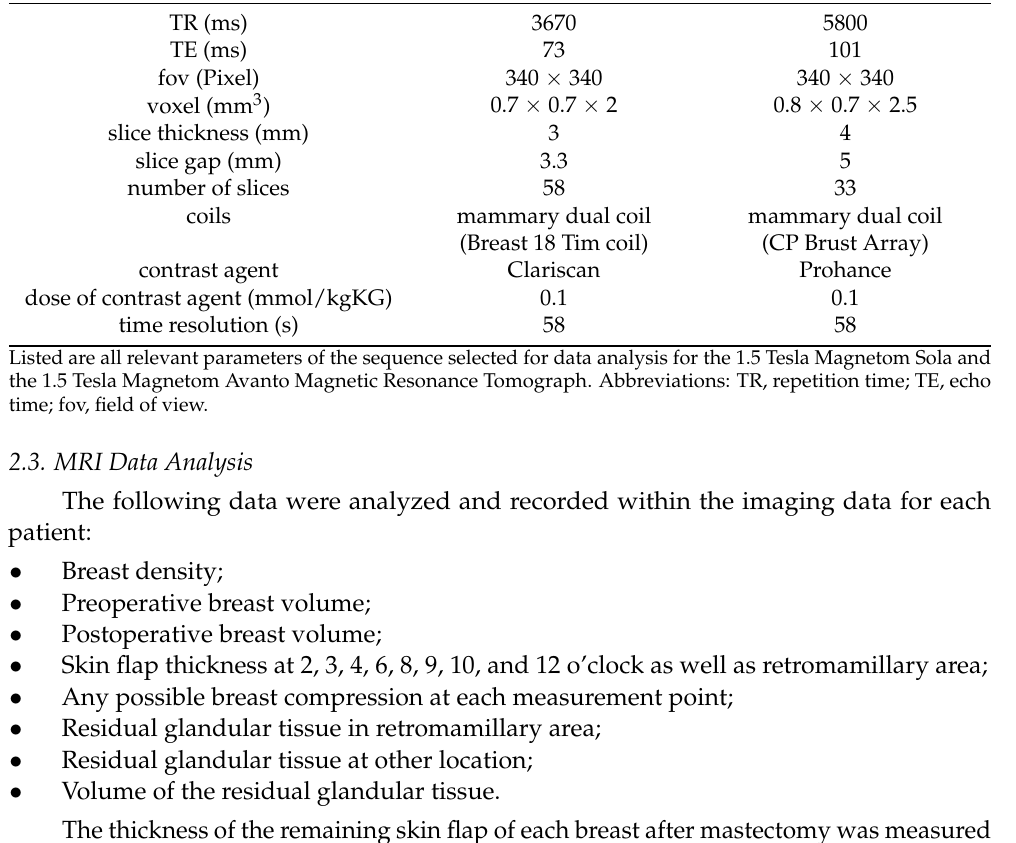
Table 2. Parameters and settings of the selected T2 TSE MRI sequence of both used devices. Parameter Magnetom Sola Magnetom Avanto TR (ms) 3670 5800 TE (ms)